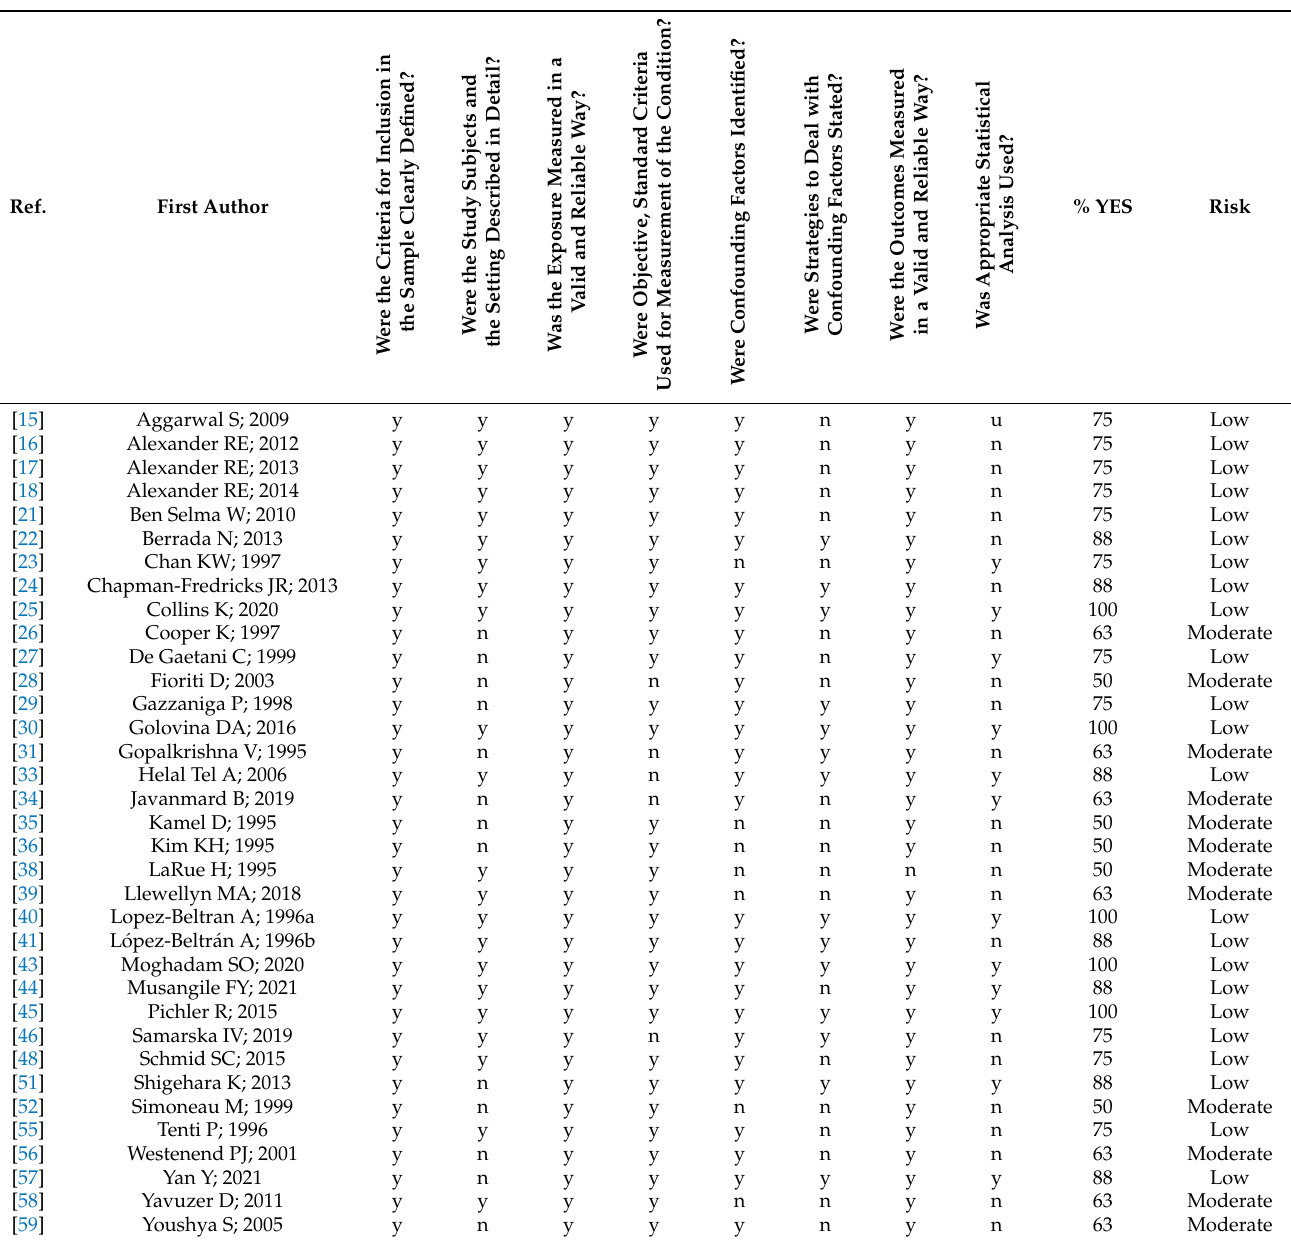
Table 2. JBI risk of bias assessment table. Eight items per study were evaluated and the risk of bias was calculated on the number of positive answers. y = yes, n = no, u = unclear. Moderate = where positive answers were between 50% and 75%; low = where positive answers were above